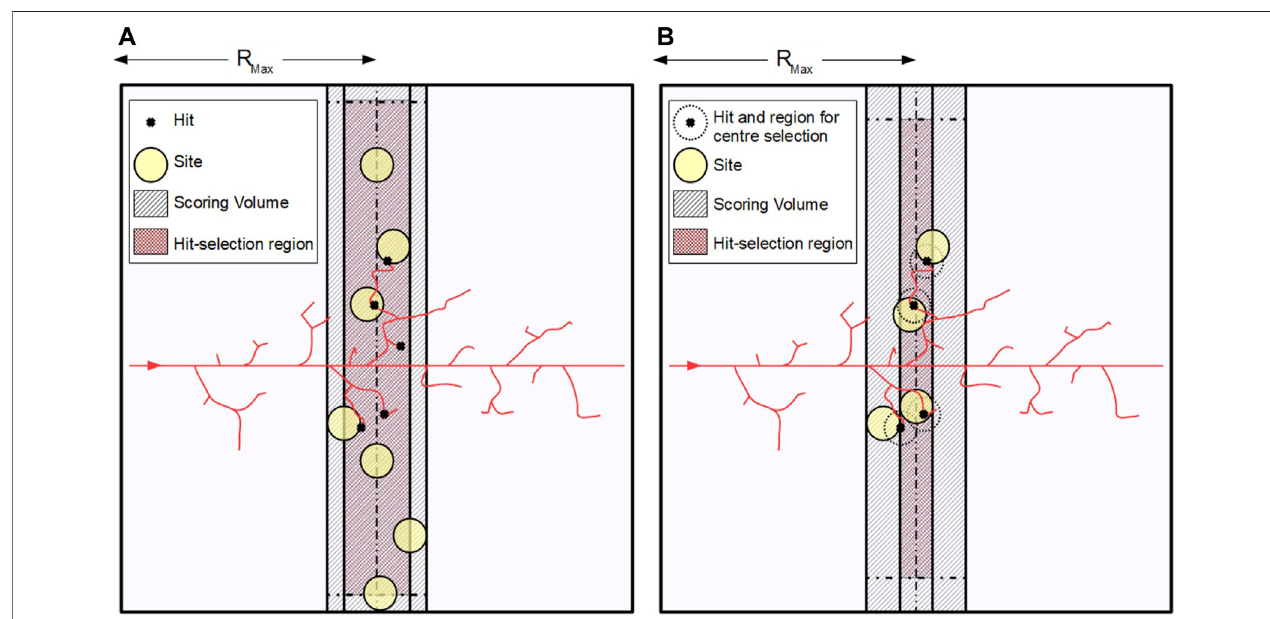
FIGURE2 | Graphical representation of the working principle ofthe twosampling algorithms: (A) uniform sampling and (B) weighted sampling. In both cases, a hit selection region (maroon shaded area) is identi fi ed, where the centers of the sites (yellow circles) are sorted. The dimensions of this region depend on the sampling algorithm used and on the diameter of the site, as lateral margins must be left to ensure that the site is always fully included in the scoring volume. For uniform sampling this margin must be set equal to the site radius, while for weighted sampling the margin is equal to the site diameter.